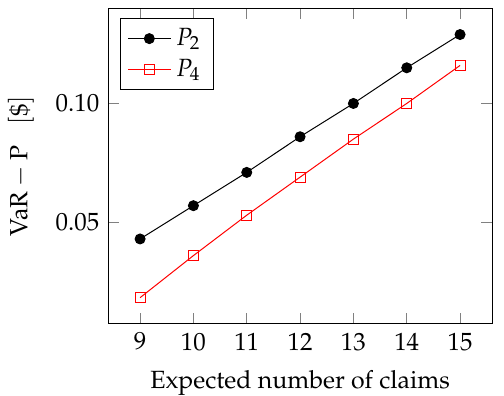
Figure 9. Insurer’s extreme loss in the Gamma case (distribution parameters as in Table